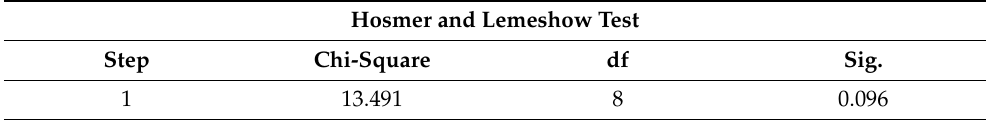
Table 14. Hosmer and Lemeshow test